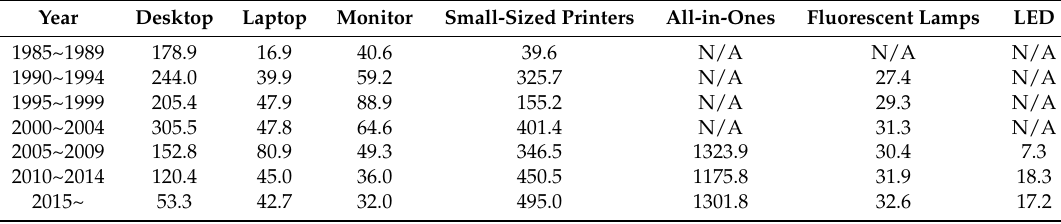
Table 6. Weighted average of the power consumption for each internal heat source (Unit: